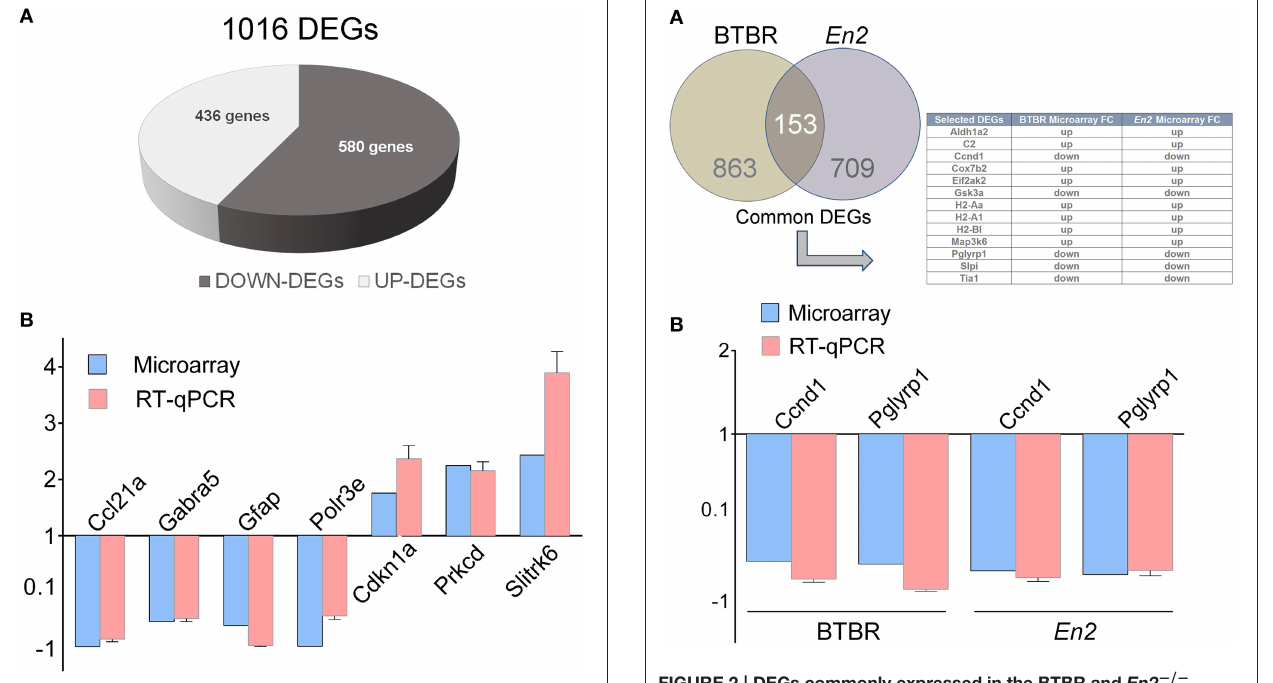
FIGURE 1 | Differentially expressed genes in the BTBR hippocampus. (A) Schematic representation of BTBR hippocampal DEGs, as compared to control B6 mice. A total of 1016 DEGs were identified, (580 down-regulated, 436 up-regulated). (B) qRT-PCR validation of differentially expressed genes. qRT-PCR results for all the evaluated genes were in agreement with microarray results. Values are expressed as each gene/L41 comparative quantitation ratios normalized on the expression of WT (mean ± s.e.m of three replicates from pools of six animals per genotype; p < 0.05, Student’s t -test, BTBR vs. B6).